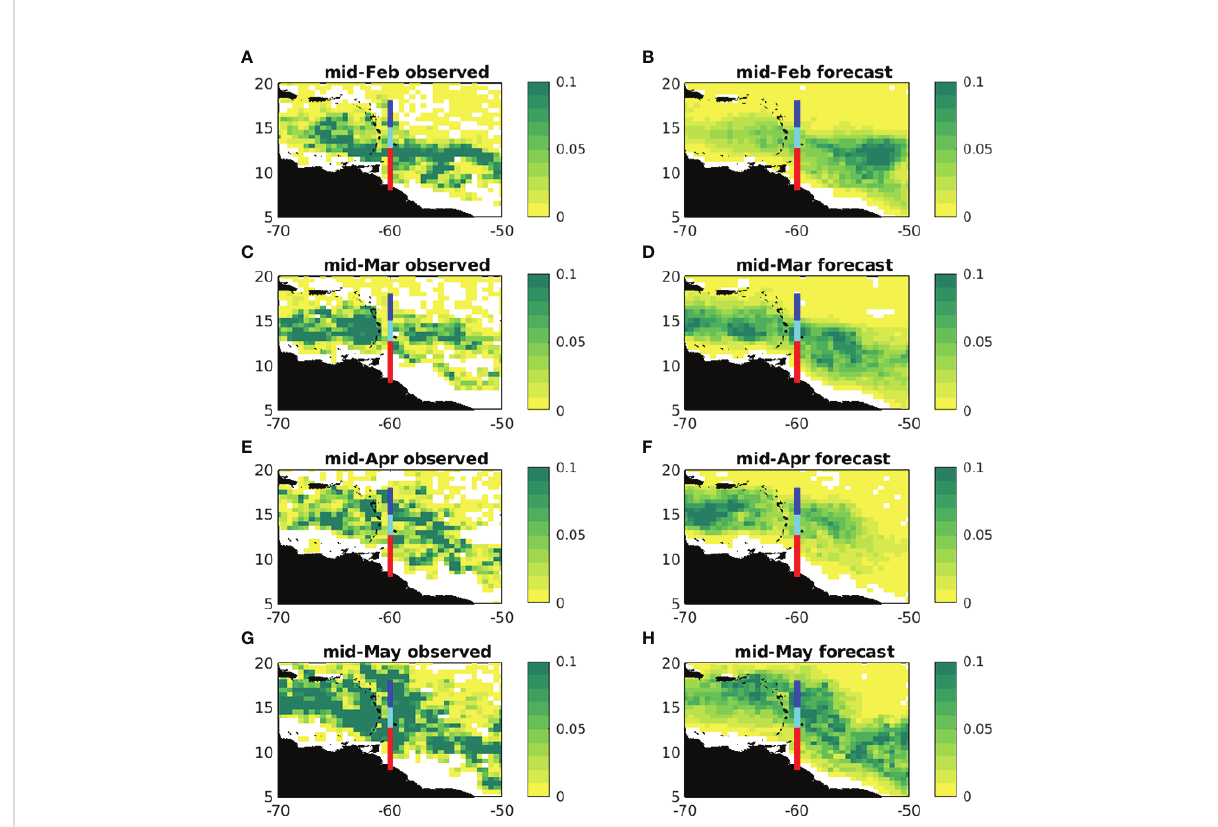
FIGURE 2 Floating algae areal fraction (aggregated in 0.5° grid cells), observed by satellite (left) and in ensemble forecasts after 1 month (right): (A, B) mid- February; (C, D) mid-March, (E, F) mid-April; (G, H) mid-May. Also indicated are zones for forecasting sargassum fl uxes across 60°W ( ‘ South ’ , from the South American coast to 12.75°N, in red; ‘ Middle ’ , 12.75-15°N, in cyan; ‘ North ’ , 15-18°N, in